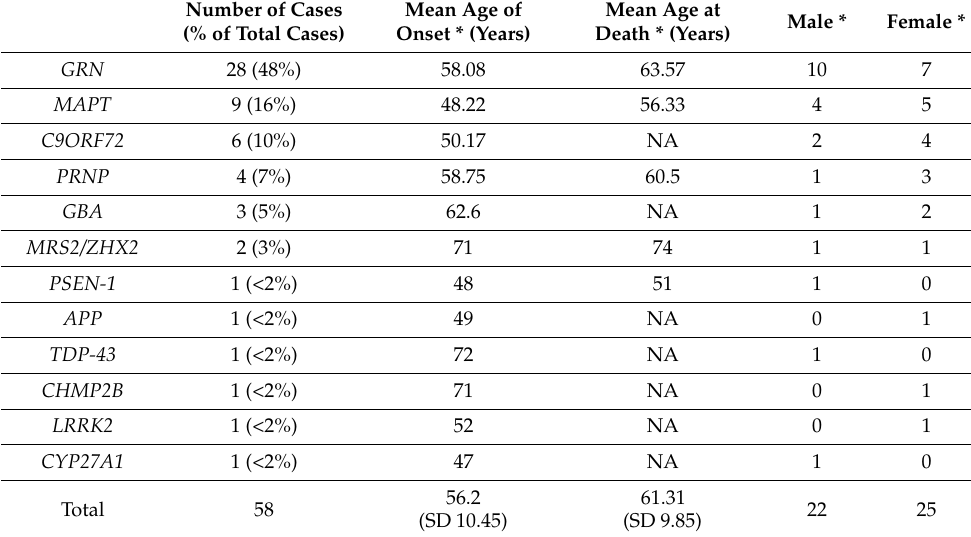
Table 1. Demographic information of genetic corticobasal syndrome (CBS) cases included in the analysis. * indicates that values were taken only where